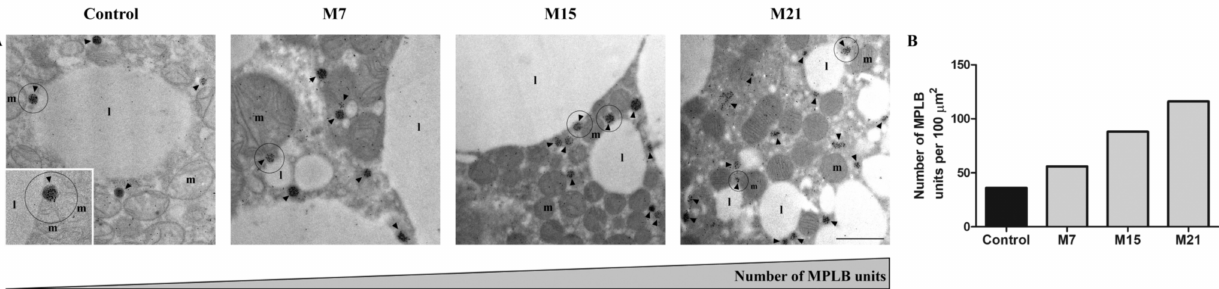
Figure 4. Close structural association of mitochondria, peroxisomes, and lipid bodies–MPLB units in brown adipocytes of control and hypothyroid groups treated with methimazole for 7 (M7), 15 (M15), and 21 (M21) days, respectively. At the electron micrographs, MPLB units were represented by circles ( A ), and their number increased with the time course ( B ). The number of MPLB units were presented as relative to 100 µ m 2 of cell area. Additionally, immunogold labeling of catalase (CAT) was shown. l, lipid body; m, mitochondria; n, nuclei; arrowhead, peroxisomes. Scale bar 1 µ m.